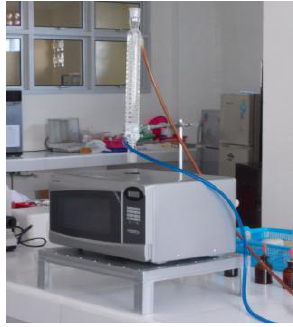
Figure 1. Modified microwave